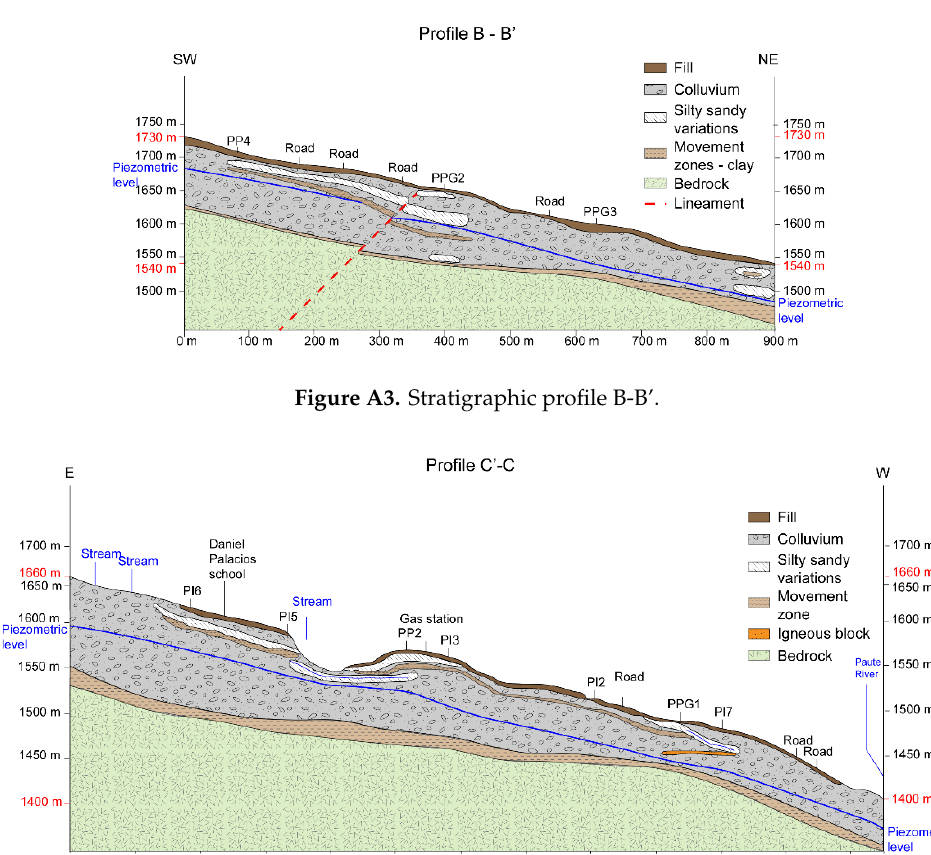
Figure A4 . Stratigraphic profile C ’ -C.